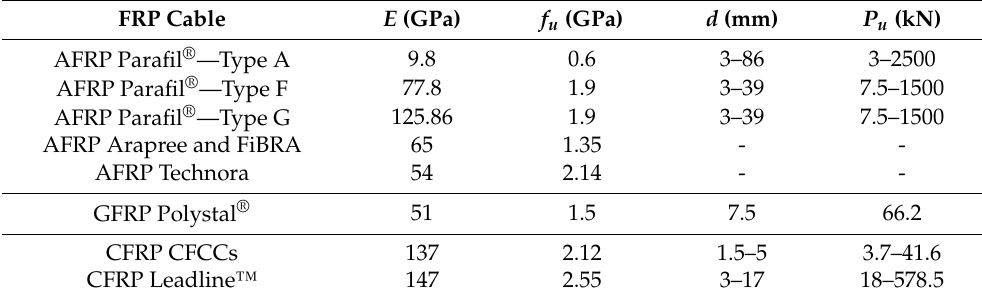
Table 1. FRP composite tendons: Young’s modulus ( E ), strength ( f u ), and breaking load ( P u